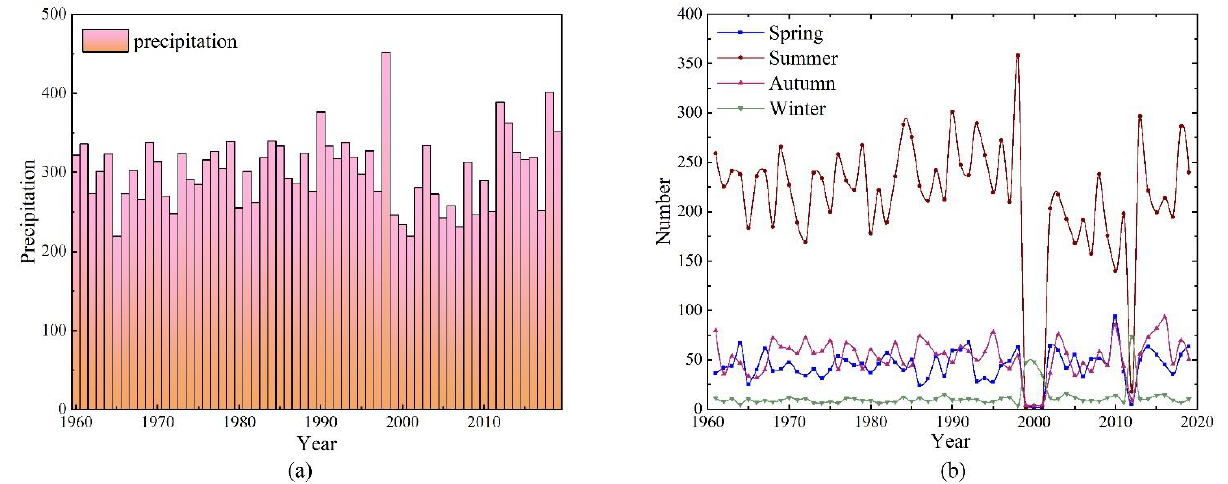
Figure 3. ( a ) The time series for the annual precipitation of the study area. ( b ) The time series for the precipitation for different seasons.